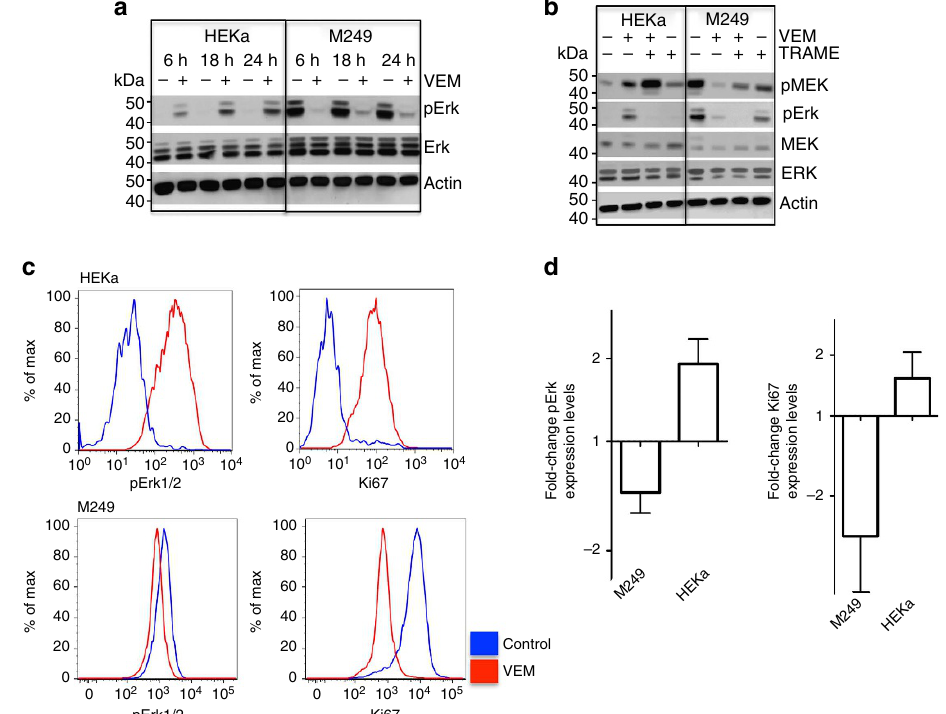
Figure 1 | BRAF inhibition induces paradoxical MAPK activation in keratinocytes (HEKa). ( a ) Western blot analyses of pERK in HEKa compared with the BRAF V600E mutant melanoma cell line M249 when treated with vemurafenib. ( b ) Levels of pERK and pMEK in HEKa compared with the BRAF V600E mutant melanoma line M249 when treated with vemurafenib (VEM), trametinib (TRAME) or the combination for 24h. ( c ) Histograms of intracellular flow cytometry analyses of HEKa and M249 cells treated with vehicle or vemurafenib (1.5 m M) and stained with pERK and Ki67 (staining controls represented in Supplementary Fig. 6). ( d ) Quantification of fold-change of pERK and Ki67 levels in three replicate cultures of HEKa and M249 cells treated with vemurafenib compared to vehicle. Error bars, mean ± s.d.; n ¼ 3. Results are representative of two experiments. NATURE COMMUNICATIONS|7:12348|DOI: